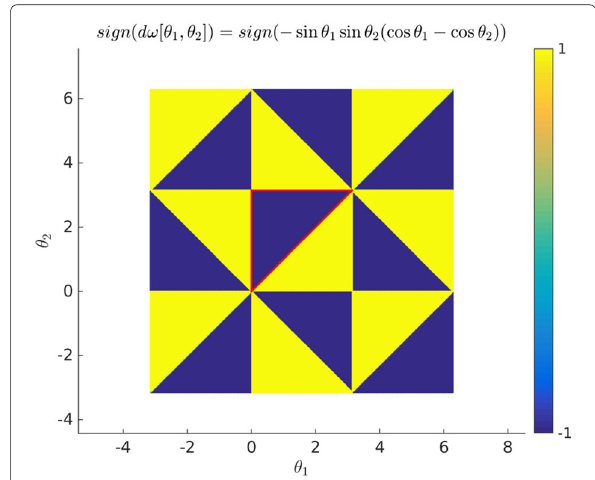
Fig. 4 Sign of the two form d ω on the covering